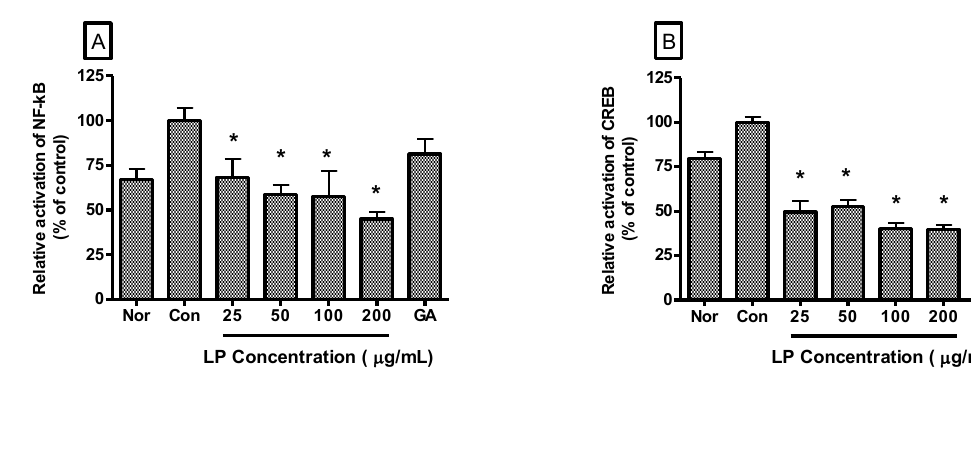
Relative activation of NF-κB in LPS-induced RAW 264.7 cells incubated with LP at concentrations of 25, 50, 100 and 200 μg/mL for 4 h were 68.41% ± 10.1%, 58.79% ± 5.29%, 57.55% ± 14.22% and 45.09% ± 3.77% ( p < 0.05) of the control (1 μg/mL of LPS alone) value, respectively (Figure 5A). And relative activation of CREB in LPS-induced RAW 264.7 cells incubated with LP at concentrations of 25, 50, 100 and 200 μg/mL for 4 h were 49.57% ± 6.27%, 52.74% ± 3.54%, 40.1% ± 3.36% and 39.82% ± 2.29% ( p < 0.05) of the control (1 μg/mL of LPS alone) value, respectively (Figure 5B). Figure 5. Effects of LP on NF-κB ( A ) and CREB ( B ) activation in LPS-stimulated RAW 264.7 macrophages. Nuclear localized NF-κB and CREB were quantified using a Procarta Transcription Factor Plex assay after 4 h incubation. Normal group (Nor) was treated with medium only. Control group (Con) was treated with LPS (1 μg /mL) alone. As a reference material, gallic acid (GA; 100 μM), one of important anti-oxidative and anti-inflammatory compounds, was treated with LPS for 4 h. Values are the mean ± SEM of three independent experiments. * p < 0.05 vs.